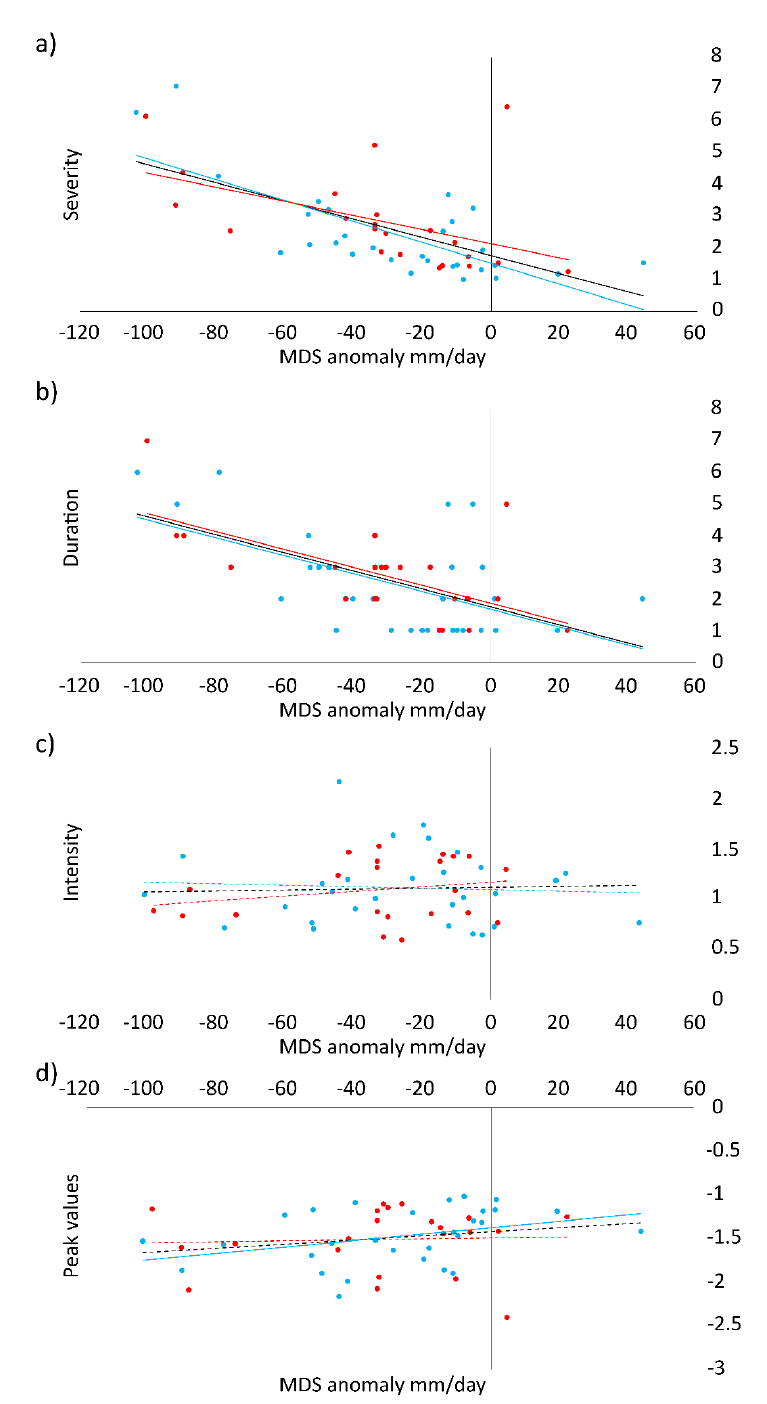
Figure 5. Scatterplot: moisture supply anomalies from the MDS (x-axis, mm/day) and the severity ( a ); duration ( b ); intensity ( c ) and peak values ( d ) of drought episodes at the annual (entire period shown by both blue and red dots), onsets in winter (March–October) (blue dots) and summer (April–September) (red dots) scales. Corresponding regression lines are also shown: RLA (S) represents Regression Line Annual Significant; RLW (S) represents Regression Line Winter Significant; RLS (S) represents Regression Line Summer Significant; RLA (NS) represents Regression Line Annual Nonsignificant; RLW (NS) represents Regression Line Winter Nonsignificant; and RLS (NS) represents Regression Line Summer